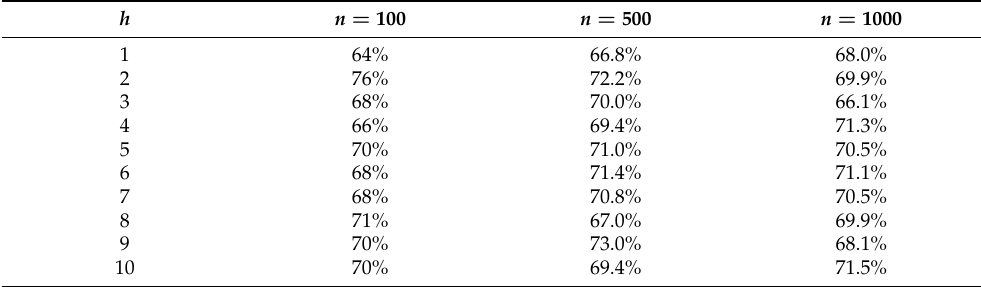
Table 4. Percentages of acceptable values for the residuals series in Equation (8) tested with the RJB method and repeated for h = 1, . . . ,10, with significance level α = 0.02 and different values of n . h n = 100 n = 500 n = 1000 1 64% 66.8% 68.0% 2 76% 72.2% 69.9% 3 68% 70.0% 66% 69.4% 70% 71.0%